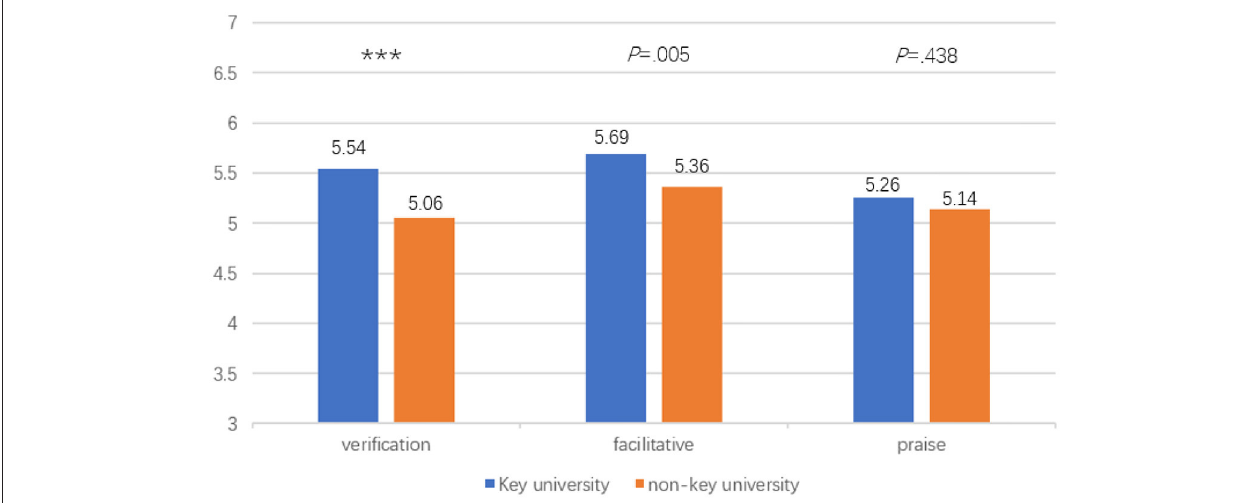
FIGURE 1 | Mean differences of teacher feedback practices between students from the key and non-key university. *** p < 0.001.